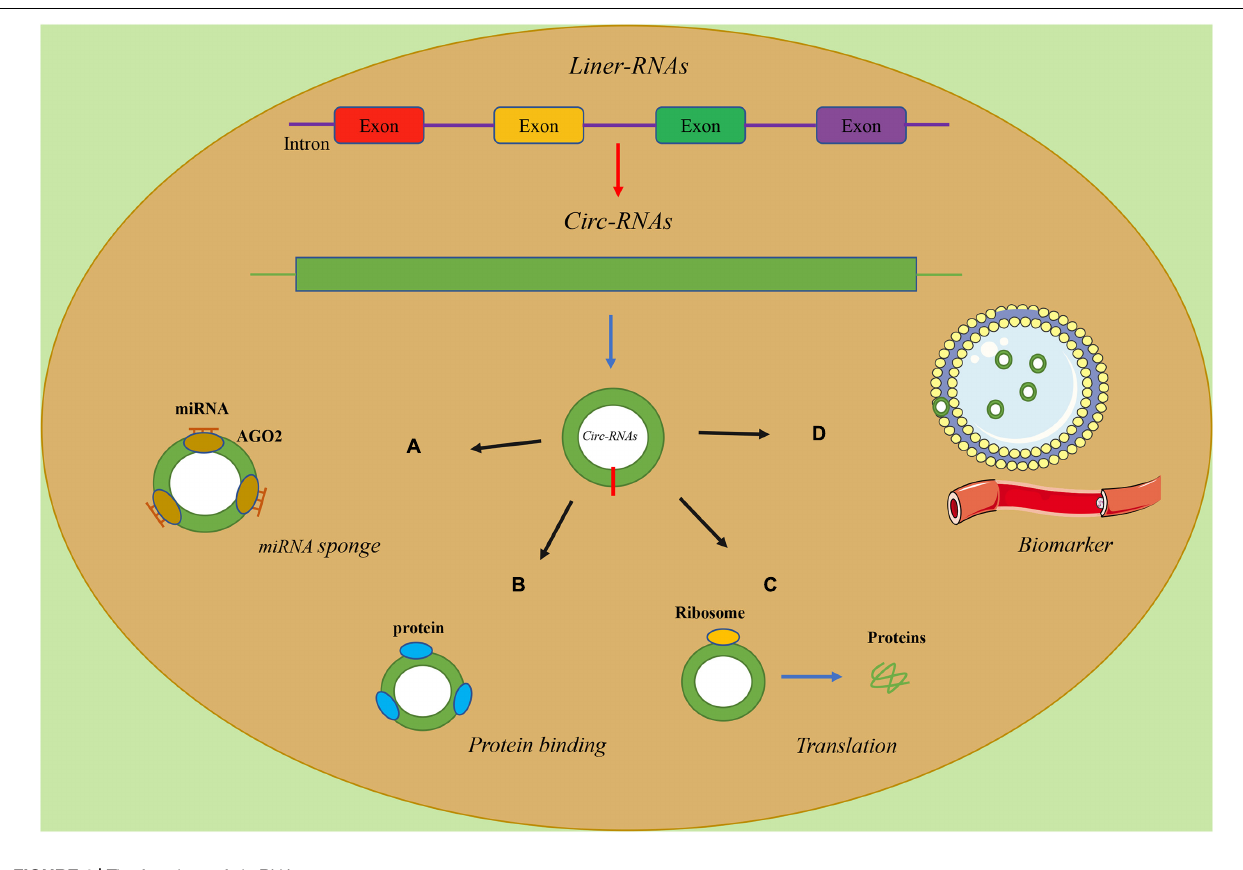
FIGURE 1 | The functions of